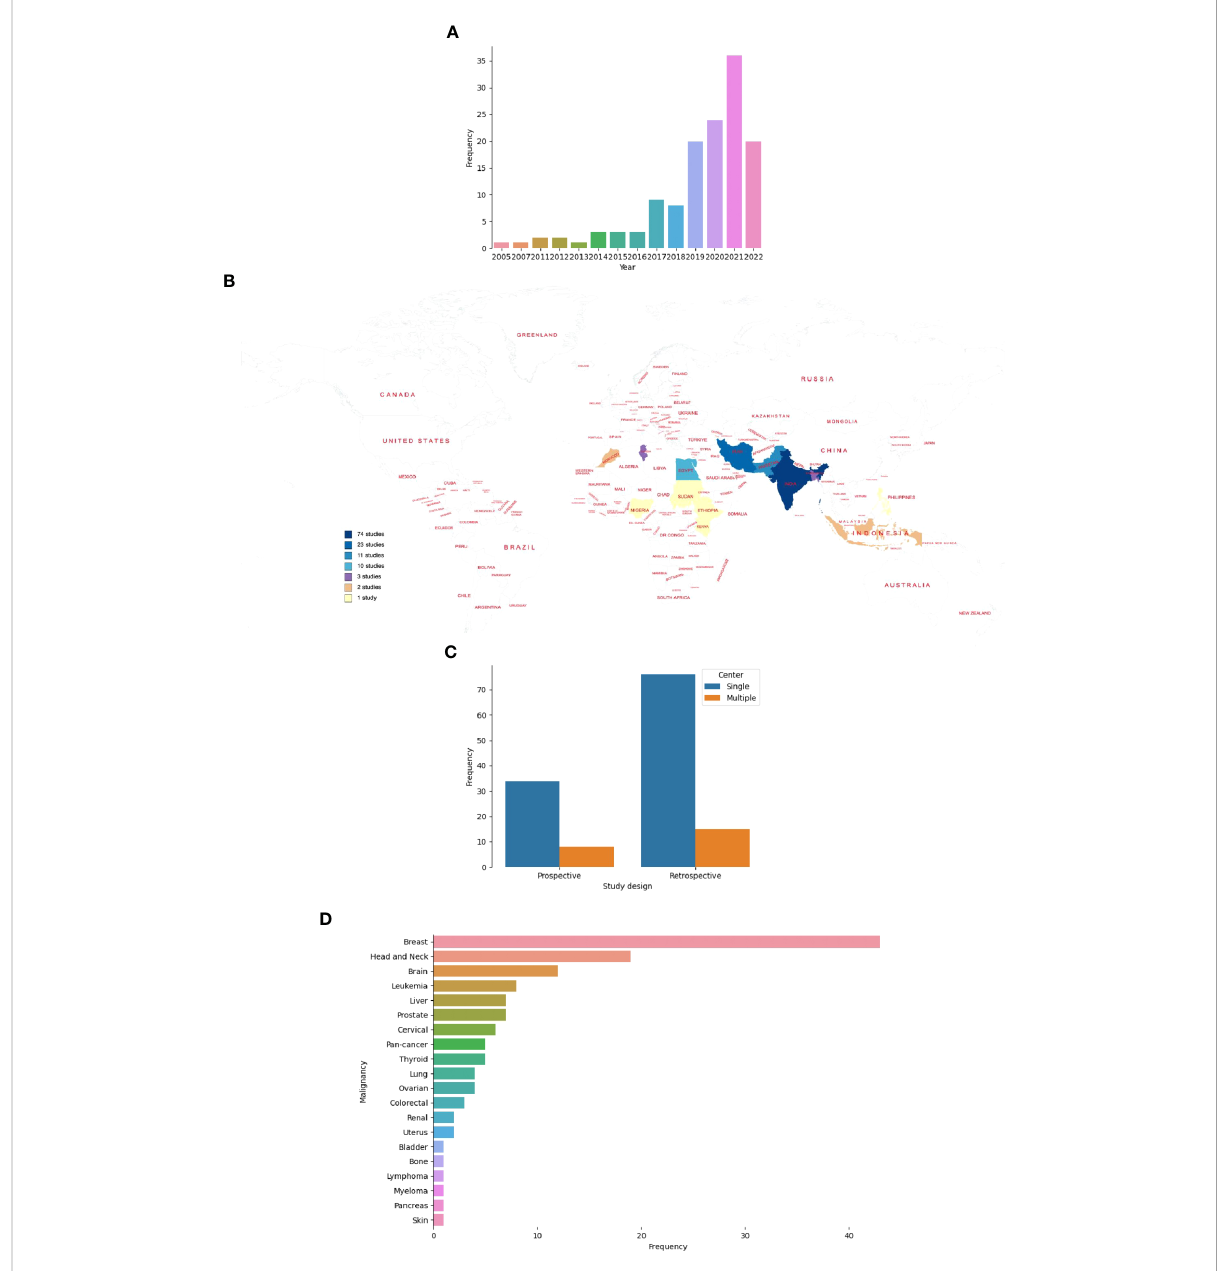
FIGURE 3 Characteristics of studies on ML-based models for cancer outcomes in LLMICs. (A) Bar plot showing the frequency of studies by publication year (B) Geographic distribution of studies on ML-models for cancer in LLMICs by country (C) Bar plot showing the study design and number of centers involved during model construction (D) Plot showing the frequency of cancers for which models were developed in the LLMIC